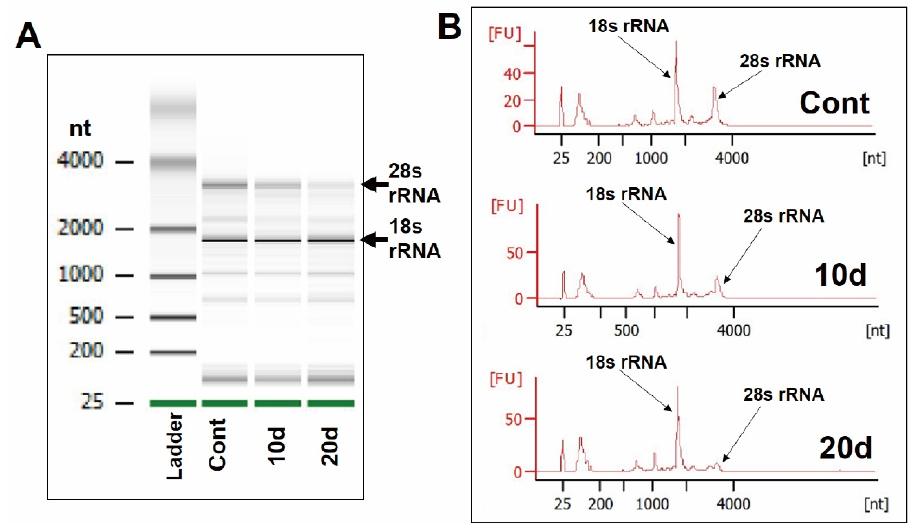
Figure 2. Electrophoresis patterns of the RNAs from RBCs in each storage condition. ( A ) Gel image and ( B ) histogram in the Bioanalyzer.